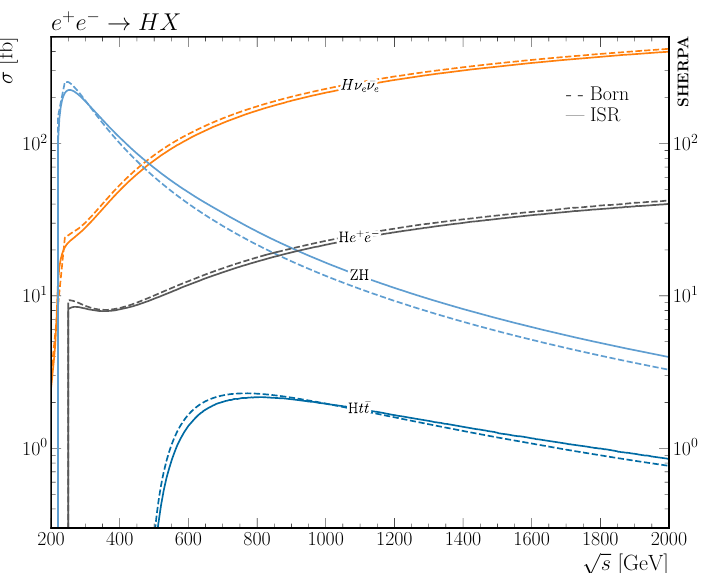
Figure 8: Total cross-section for e + e − → HX at the Born level and with ISR correc- tions included. For the ISR we include the perturbative corrections up to